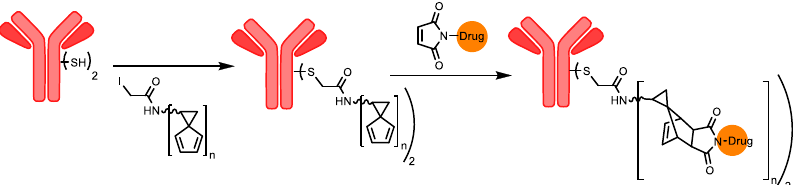
Figure 1. Schematic representation of the strategy for attaining high-drug to antibody ratio (DAR) antibody–drug conjugates (ADCs) in a site-specific manner.